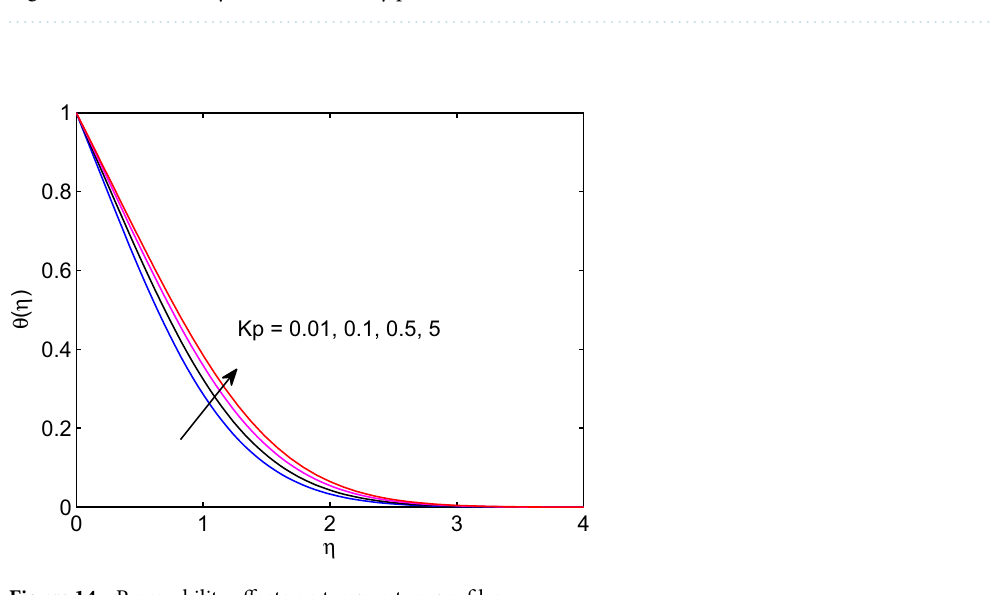
Figure 14. Permeability effects on temperature